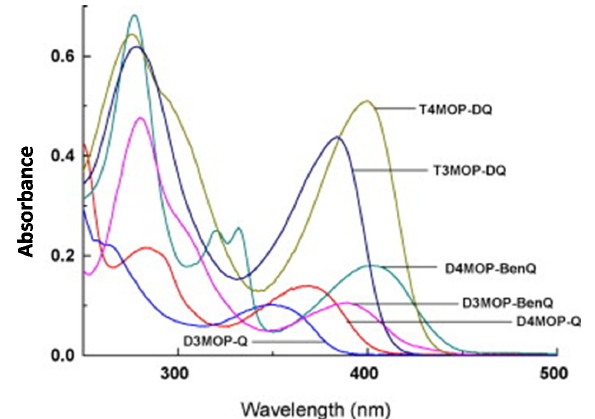
Figure 28. UV-visible absorption spectra of MOPQs in chloroform. Reprinted from Ref. [240] , Copyright 2010, Elsevier.